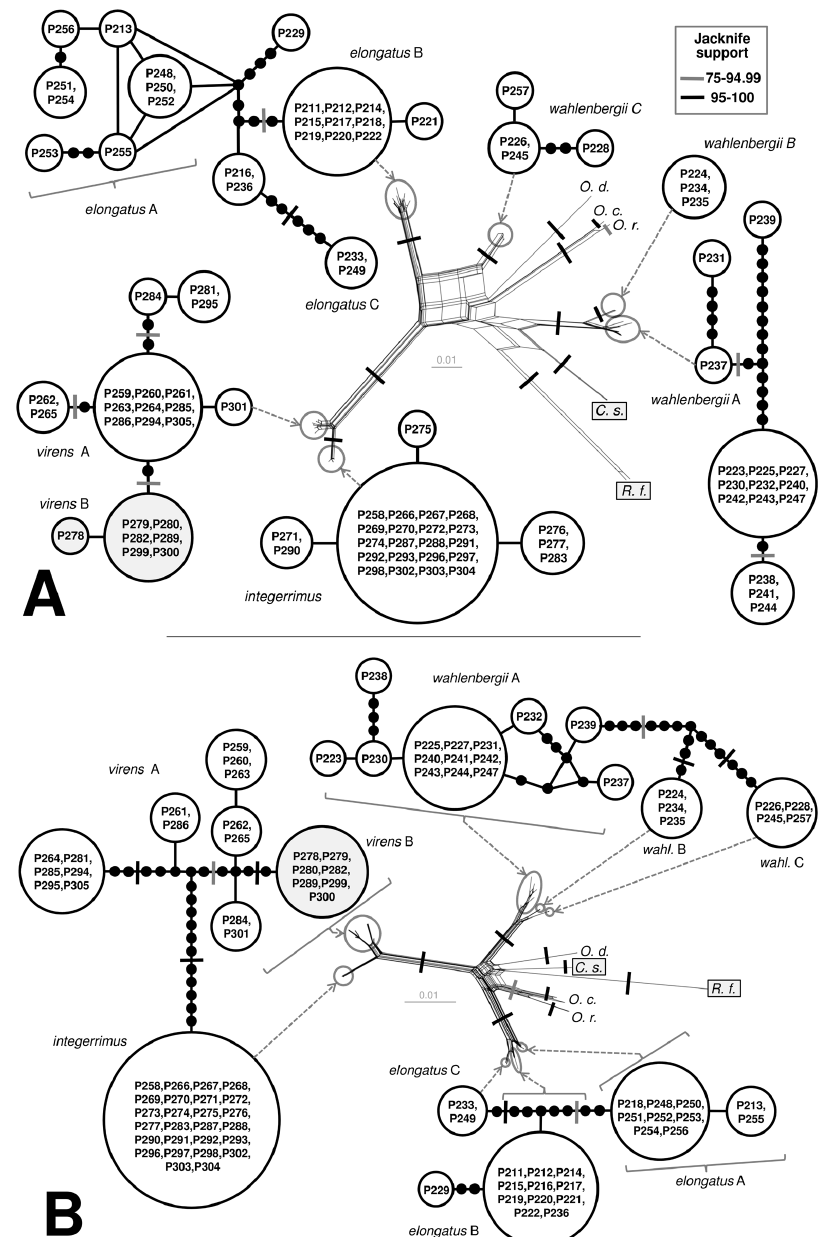
Fig. 1. NeighborNet split network for the 104 specimens studied, based on ITS ( A ) and the chloroplast markers trn G and rps 4 ( B ): Oncophorus crispifolius ( O.c. , 2 specimens), O. dendrophilus ( O.d. , 2), O. elongatus (24), O. rauei ( O.r. , 2), O. virens (22), O. wahlenbergii (22), O. integerrimus Hedenäs sp. nov. (26), and outgroup (light grey boxes: C.s. = Cynodontium strumiferum , 2; R.f. = Rhabdoweisia fugax , 2). Haplotype networks based on all samples of O. elongatus , O. virens , O. wahlenbergii , and O. integerrimus Hedenäs sp. nov. are shown distal to ‘branches’ identified in the split network to show the full resolution among haplotypes. Circle size in the haplotype networks is proportional to the number of sampled populations of a certain haplotype, and sample numbers are explained in Table 1. Circles connected by a line differ in a single mutational difference; black dots indicate ‘missing’ haplotypes. Jacknife support values of 75–94.99 and 95–100 are indicated by transverse grey and black lines,